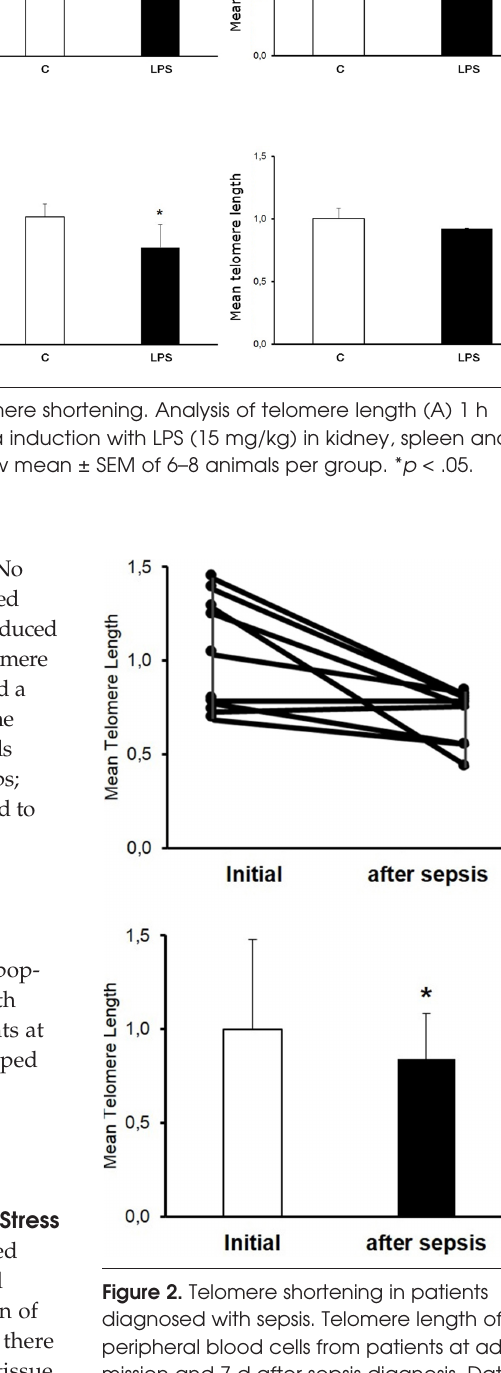
Figure 2. Telomere shortening in patients diagnosed with sepsis. Telomere length of peripheral blood cells from patients at ad- mission and 7 d after sepsis diagnosis. Data show mean ± SEM of 9 patients. * p <